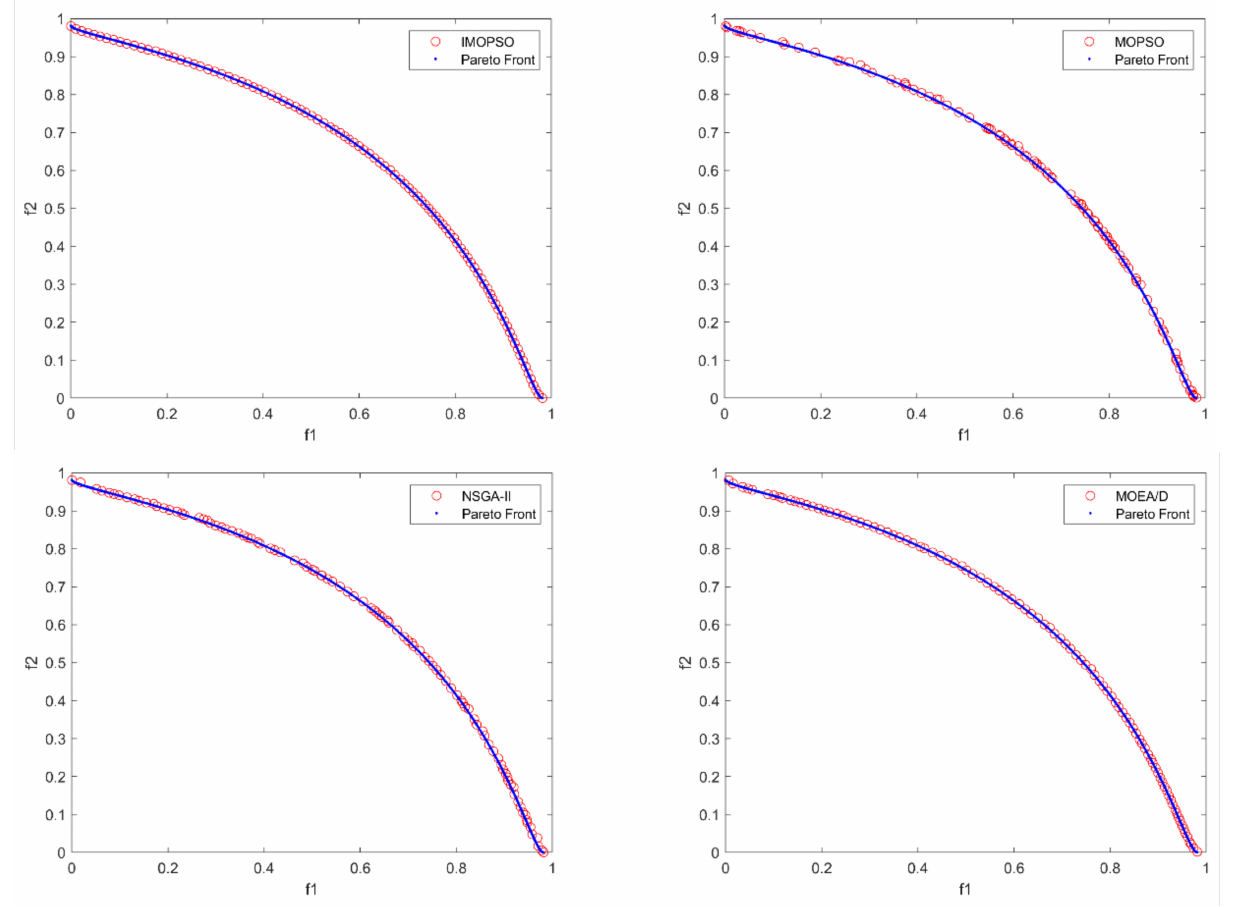
Figure 6. Comparison of the results of four algorithms for solving FON function.